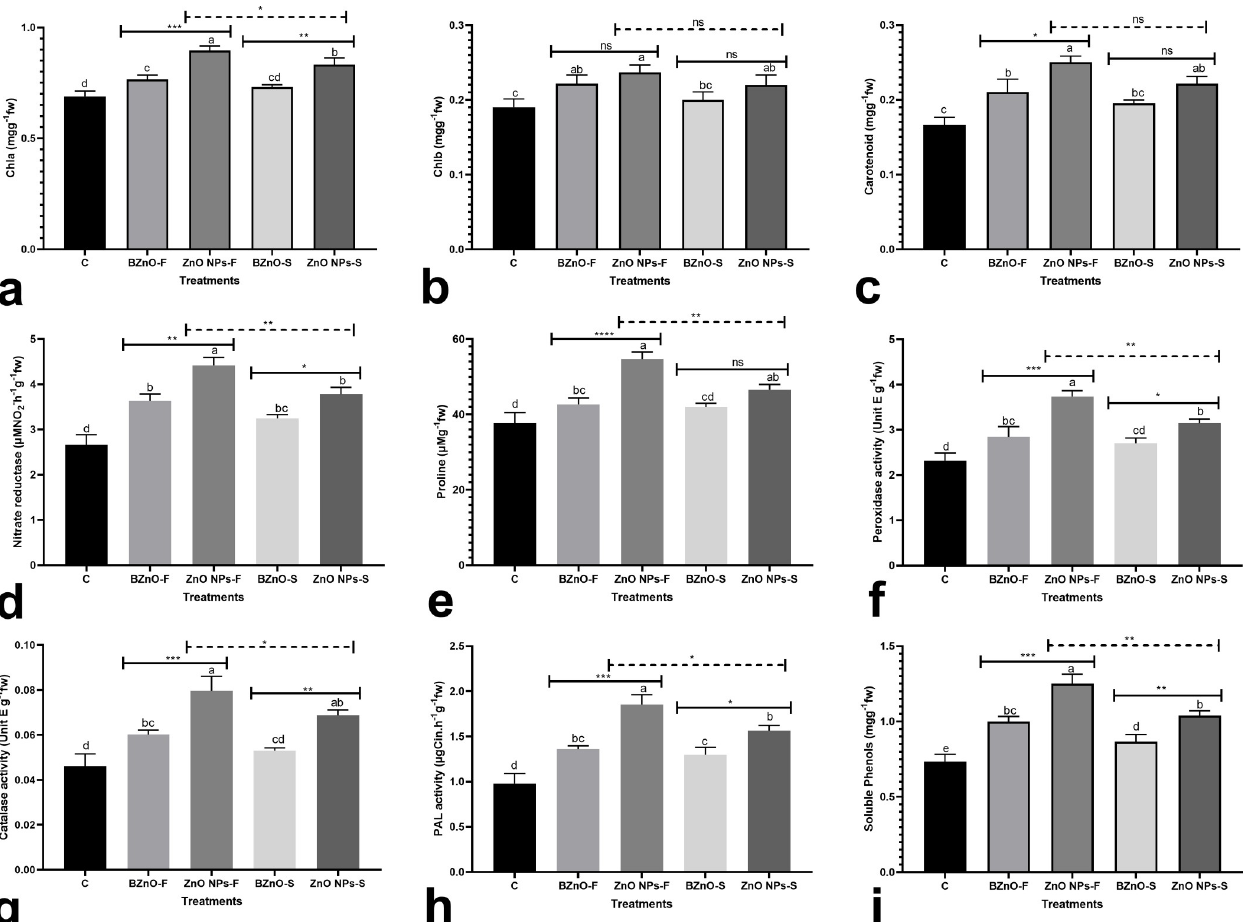
Fig 3. The BZnO or ZnONP-mediated changes in several physiological traits, including Chl a [a], Chl b [b], carotenoids [c], nitrate reductase [d], proline [e], peroxidase activity [f], catalase activity [g], PAL activity [h], and soluble phenols [i]; The treatment groups: C: Control; BZnO-F: Foliar application of BZnO; ZnO NPs-F: Foliar application of ZnO NPs; BZnO-S: Supplementation of nutrient solution with BZnO; ZnO NPs-S: Supplementation of nutrient solution with ZnO NPs; Different letters on the columns refer to statistically significant differences according to Tukey’s multiple comparisons test. A comparison between the two BZnO and ZnO NPs groups at the same method is presented by placing an asterisk [ � ] on the line, while asterisks [ � ] on the dashed lines define the comparison between two ZnO NPs-F and ZnO NPs-S groups. ns: Non-significant; � : 0.01 < p � 0.05; �� : 0.001 < p � 0.01; ��� : 0.0001 < p � 0.001; ���� : p �